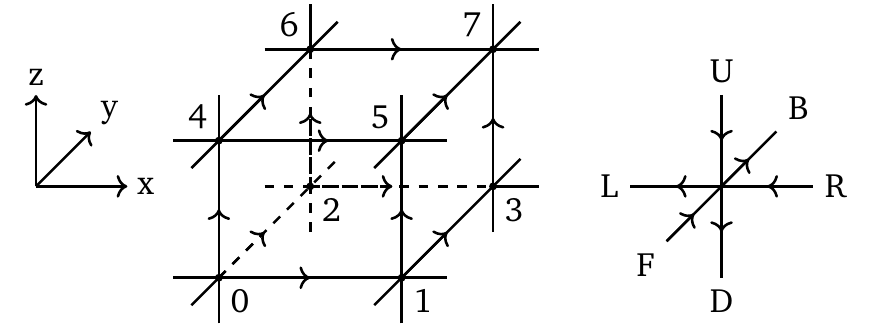
Figure 13: There are six faces for each cube c . U,D,F,B,L,R stand for faces on direction “up”,“down”,“front”,“back”,“left”,“right”. We assign the face U, F, R to be inward and D, B, L to be outward. The ∪ product on two 1 β ′ ( c ) = β ( L ) β ′ ( B ) + β ( L ) β ′ ( D ) + β ( B ) β ′ ( D ) 2-cochain is defined by β ∪ 1 + β ( U ) β ′ ( F ) + β ( U ) β ′ ( R ) + β ( F ) β ′ ( R )